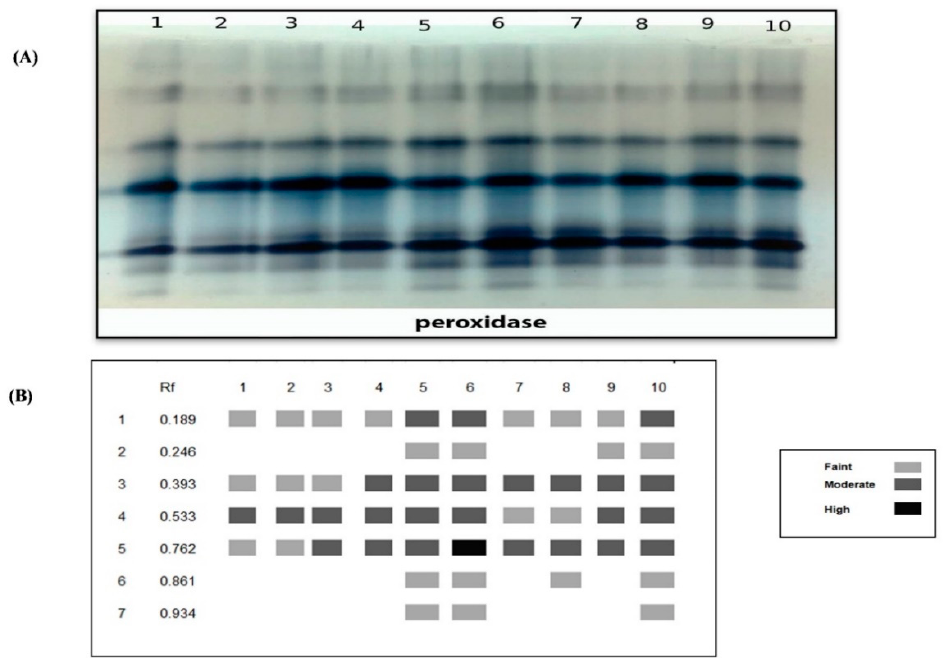
Figure 7. Effect of salinity (S) and foliar application of chitosan dissolved in different organic acids (Ch ACE, Ch ASC, Ch CIT and Ch MAL) and their interactions on ( A ) Peroxidase isozyme and ( B ) Ideogram analysis of peroxidase isozyme of tomato plants. Table 3. Isomers of peroxidase enzymes (+/ − ) and their Retention factor (Rf) in response to salinity Scheme. L1 = Control, L2 = Ch ACE, L3 = Ch ASC, L4 = Ch CIT, L5 = Ch MAL, L6 = S, L7 = S + Ch